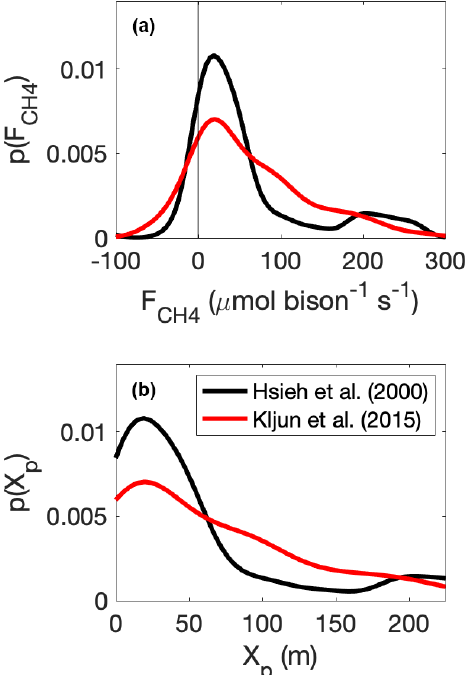
Figure 11. Kernel density estimates of the distribution ( p ) of (a) methane efflux ( F CH ) on a per-bison basis and (b) the peak 4 ( X p ) of the source-weight function for 0.5h flux footprints derived from the Hsieh et al. (2000) and Kljun et al. (2015) flux footprint models.